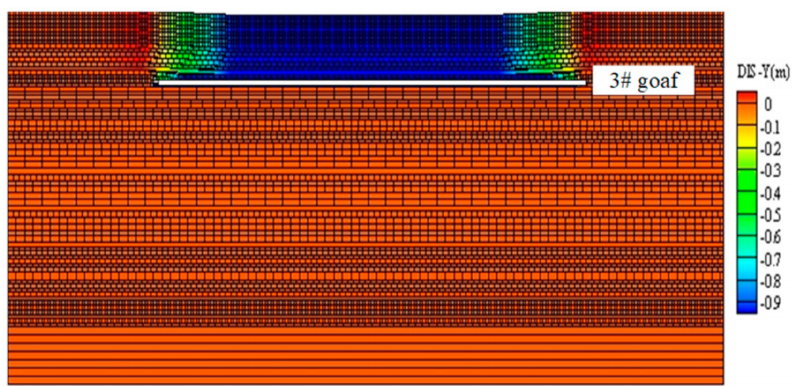
Figure 17. Displacement field of overburden after the mining of the 3# coal